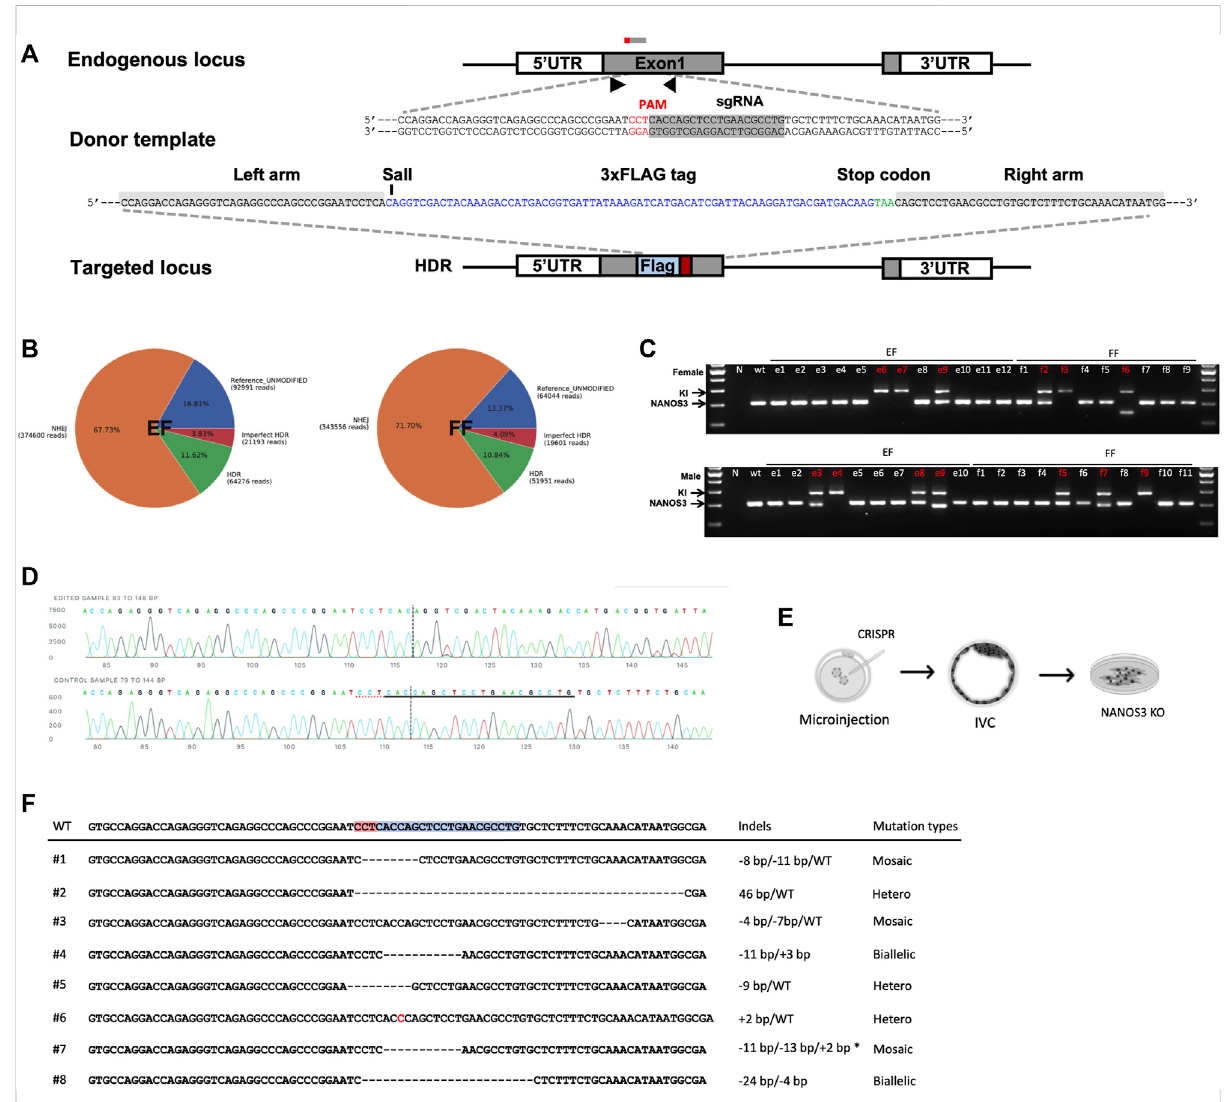
FIGURE 4 CRISPR/Cas9-mediated modi fi cation of NANOS3 in embryonic fi broblasts. (A) Strategy for disruption of NANOS3 with insertion of apremature translational-stopcodon(PTC).AcandidatessODNwasdesignedcontaininga3xFLAGepitopetagandaPTC(TAA) fl ankedby40 nthomologyarms corresponding to the region to be edited. The cassette contains restriction enzyme cut sites (SalI) to assist in RFLP-based assay. (B) Quanti fi cation and visualization of the outcomes of genome editing. Pie charts summarizing the frequencies of events in the NANOS3 loci from targeted amplicon sequencing in EF and FF cells. When an expected HDR amplicon is provided, CRISPResso classi fi es sequence reads as blue, unmodi fi ed alleles; orange, NHEJ mutations; red, imperfect HDR; green, HDR alleles as distinct outcomes. (C) Genomic sequencing showing homozygous/ heterozygousmutantDNAcarryingtheintendededit.Usingtheprimersindicatedbythearrows,theampliconsfromgenomicDNAwereresolvedon agelrevealingHDR(374bp)andwild-type(Wt,300bp)and/orNHEJ( < 300bp)fragments. (D) SangersequencingofclonalEFsshowingprecisegene knockinatthetarget site. (E) Schematicoutline for thedirectgenerationofknockout NANOS3 − / − embryonic fi broblasts fromoutgrowths. (F) Sanger sequencing of established EFs via zygotic injection shows a range of mutations at the target